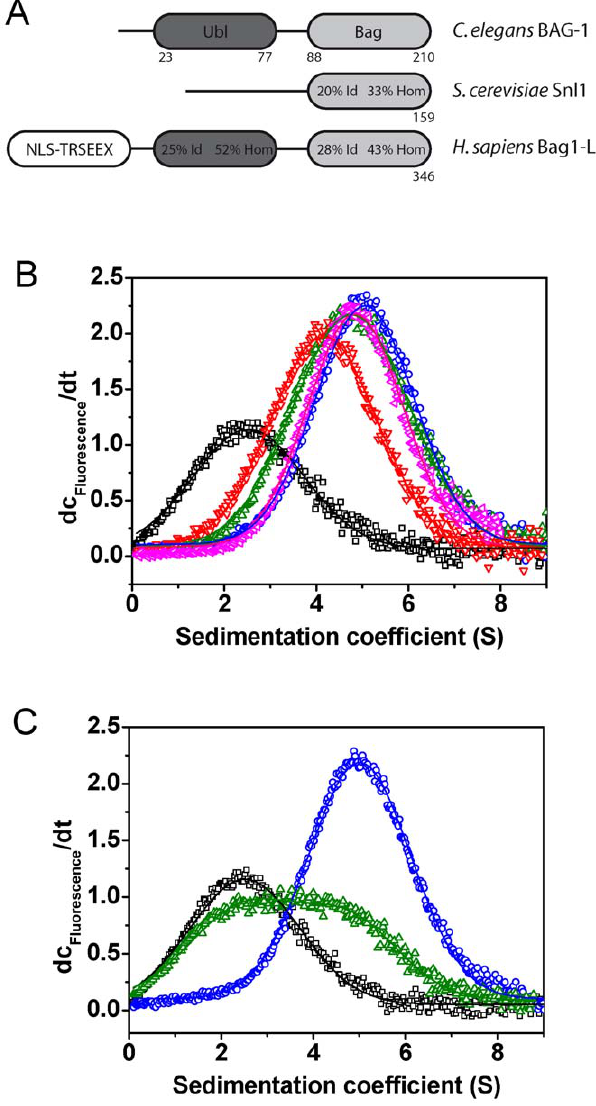
presence of 3 m M CeHsc70 (blue) or 3 m M of the isolated ATPase domain CeHsc70- D 384 (red), the full lid-deletion CeHsc70- D 512 (green) and the half-lid deletion construct CeHsc70- D 545 (pink). ( C ) dc/dt plots were generated from sedimentation velocity experiments of 300 nM *BAG-1 alone (black) or in the presence of 3 m M CeHsc70 (blue). The influence of nucleotides was analyzed by addition of 4 mM ATP